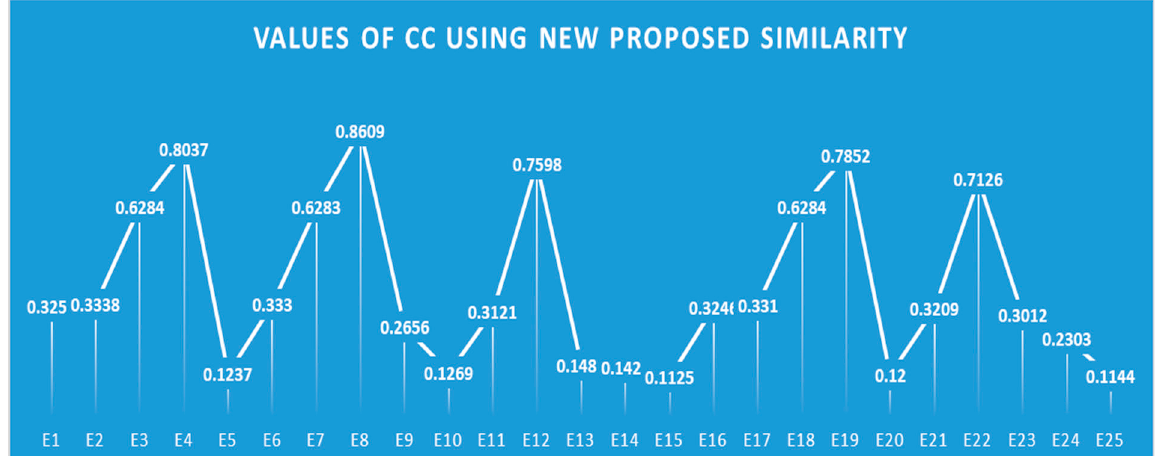
Figure 3. Values of CC using Hamming distance.